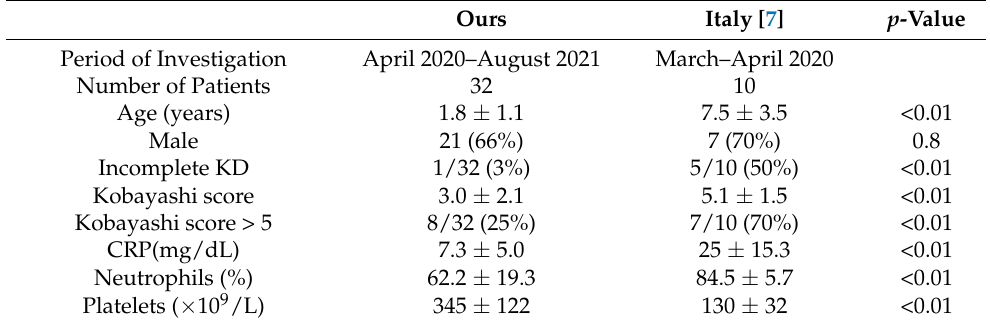
Table 2. Comparisons of the clinical data of Kawasaki disease patients in our hospital and in Italy. Ours Italy [7] p